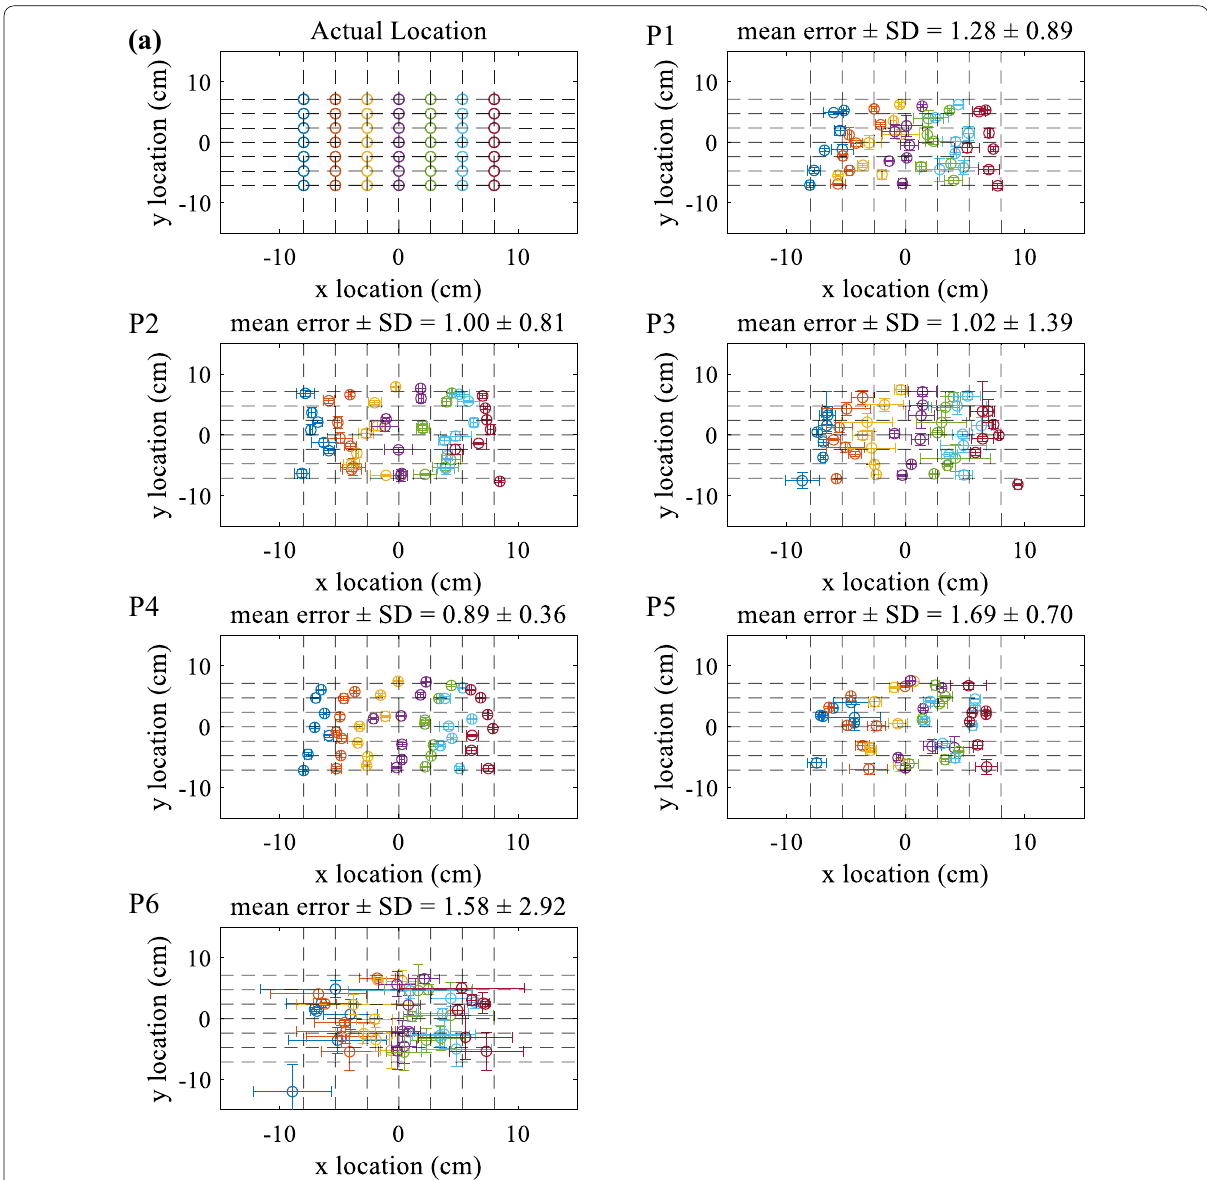
Fig. 5 Results of the general model constructed using samples from participants other than the target participant: a Actual locations of the 49 points. (P1–P6) Mean estimated location and standard deviation of each of the six participants,